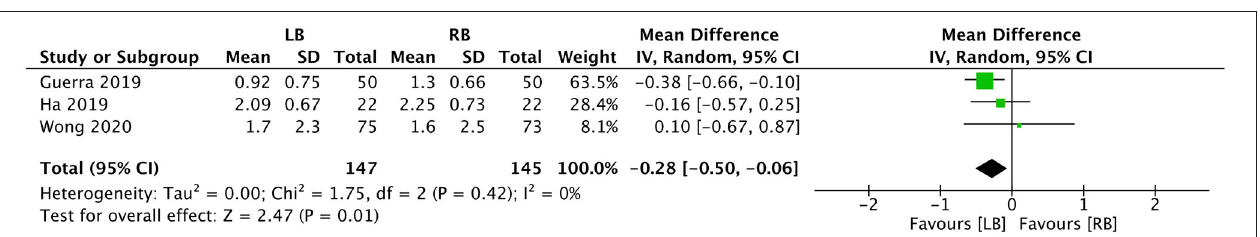
Frontiers in Surgery |